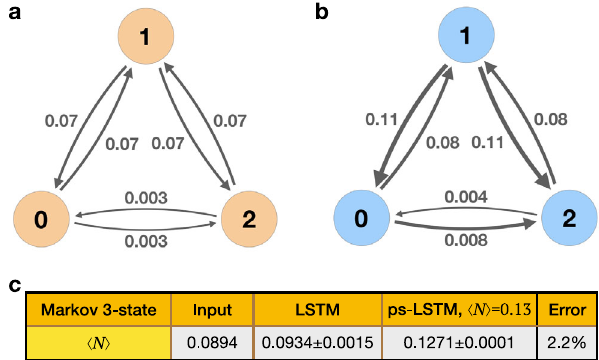
Fig. 2 | 3 state Markovian system: LSTM, ps-LSTM and analytical predictions. Here we show results of applying ps-LSTM to the 3 state Markovian system where we constrain 〈 N 〉 . In ( a ), we provide the input transitionkernelwithout constraints. In ( b ),we show the transition kernelobtained from ps-LSTMgenerated time-series via direct counting, where we achieve a 〈 N 〉 close to the target 〈 N 〉 =0.13. The cal- culated values for 〈 N 〉 are shown in ( c ) for LSTM as the average of 100 predictions and for ps-LSTM as the average of 200 predictions. The error represents “ error percentage ” which is de fi ned as the difference between ps-LSTM result and target value 〈 N 〉 =0.13 divided by the target value.